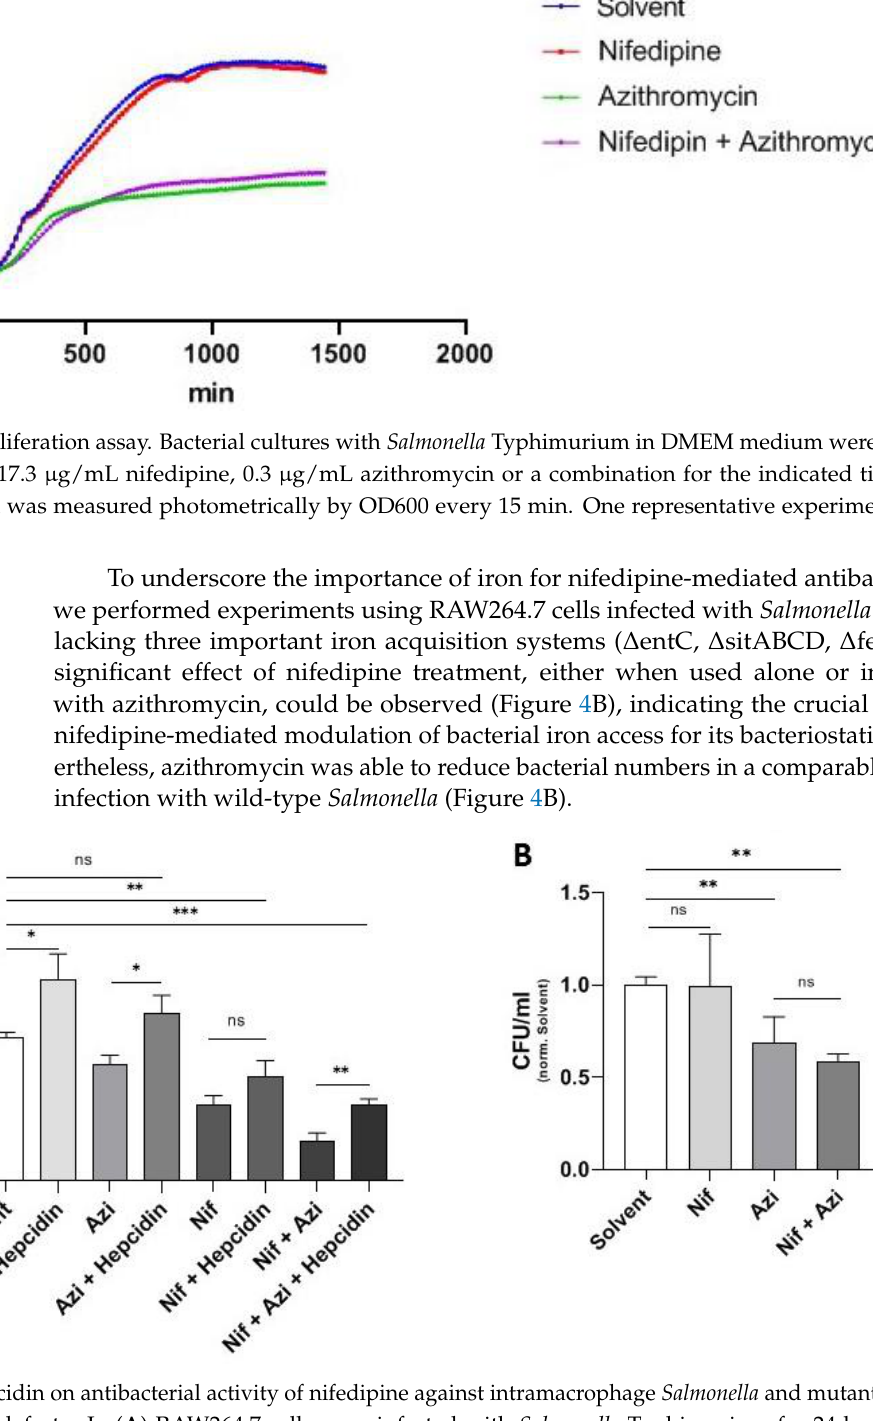
Figure 4. Effect of hepcidin on antibacterial activity of nifedipine against intramacrophage Salmonella and mutant Salmonella with iron acquisition defects. In ( A ) RAW264.7 cells were infected with Salmonella Typhimurium for 24 h and treated with nifedipine (17.3 µ g/mL), azithromycin (0.3 µ g/mL) and/or hepcidin (1 µ g/mL), as indicated. In ( B ) RAW264.7 cells were infected with Salmonella Typhimurium lacking the three main iron acquisition systems ( ∆ entC, ∆ sitABCD, ∆ feo) and treated with nifedipine (17.3 µ g/mL) and/or azithromycin (0.3 µ g/mL). Data are expressed as mean ± SEM of at least four independent experiments. Superscripts indicate statistical significance as follows: * p < 0.05, ** p < 0.01, *** p < 0.001.